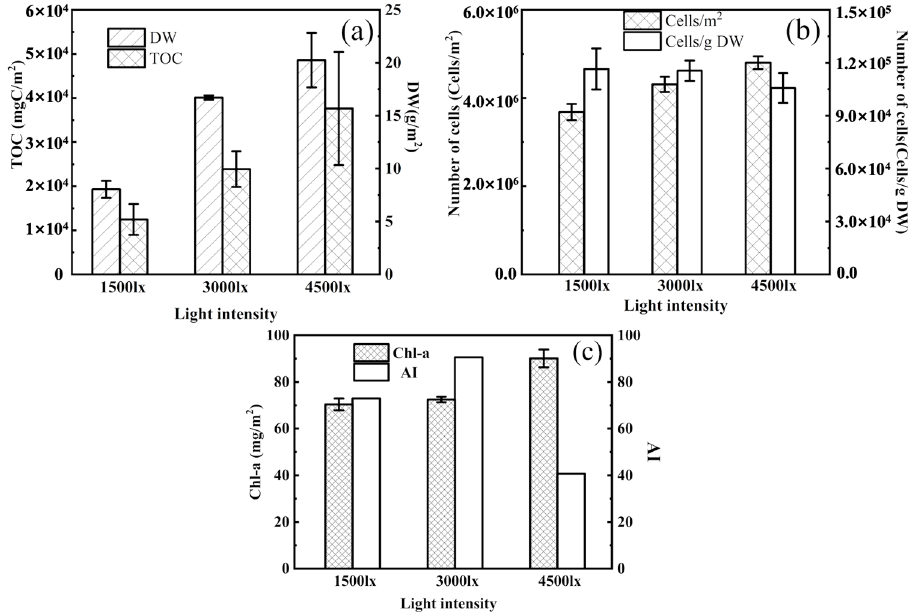
Figure 1. Effects of different light intensities on the growth of phototrophic biofilms: ( a ) ash-free dry weight (DW) and total organic carbon (TOC), ( b ) the number of cells, ( c ) the concentration of chlorophyll a (Chl-a) and autotrophic index (AI).